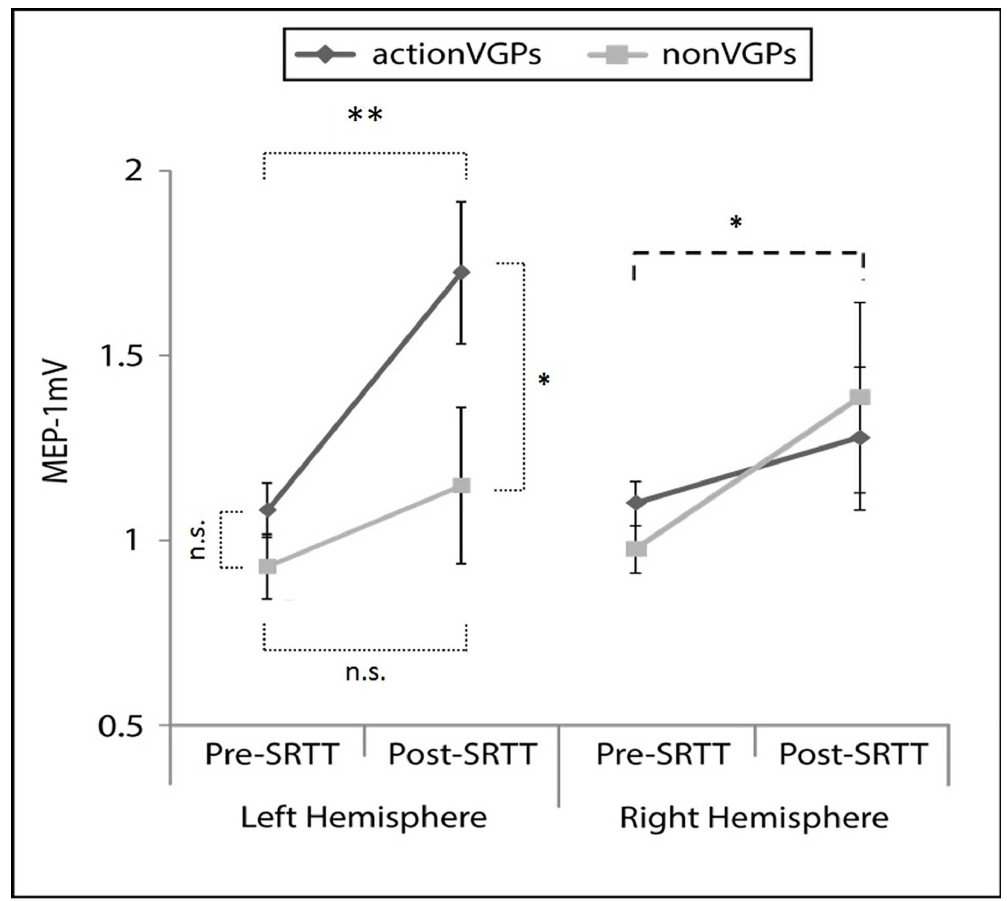
Fig 3. Measuresof cortical excitability in the motor cortical representation of the right (Left Hemisphere) first dorsal interosseus (FDI) muscle before (Pre-) and after (Post-) SRTT among actionVGPs and nonVGPs are presented here. A significant Time X Group interaction( F = 5.317; p = 0.031) indicatedincreasedMEP amplitudein the LH from Pre-SRTT to Post-SRTT for the actionVGP group ( t = 4.681; p < 0.01) while the nonVGP group remainedstable ( t = 1.788; p = 0.404). In addition,the results showeda non-significant group difference pre- SRTT ( t (22) = 1.845; p = 0.316) and a significantdifference post-SRTT ( t (22) = 2.794; p = 0.044). For the Right Hemisphere, both groups showedincreasedMEP amplitudes after the practice on the SRTT (F = 5.605; p = 0.027) without differences betweengroups (F = 0.004; p = 0.95). * p < 0.05, ** p <